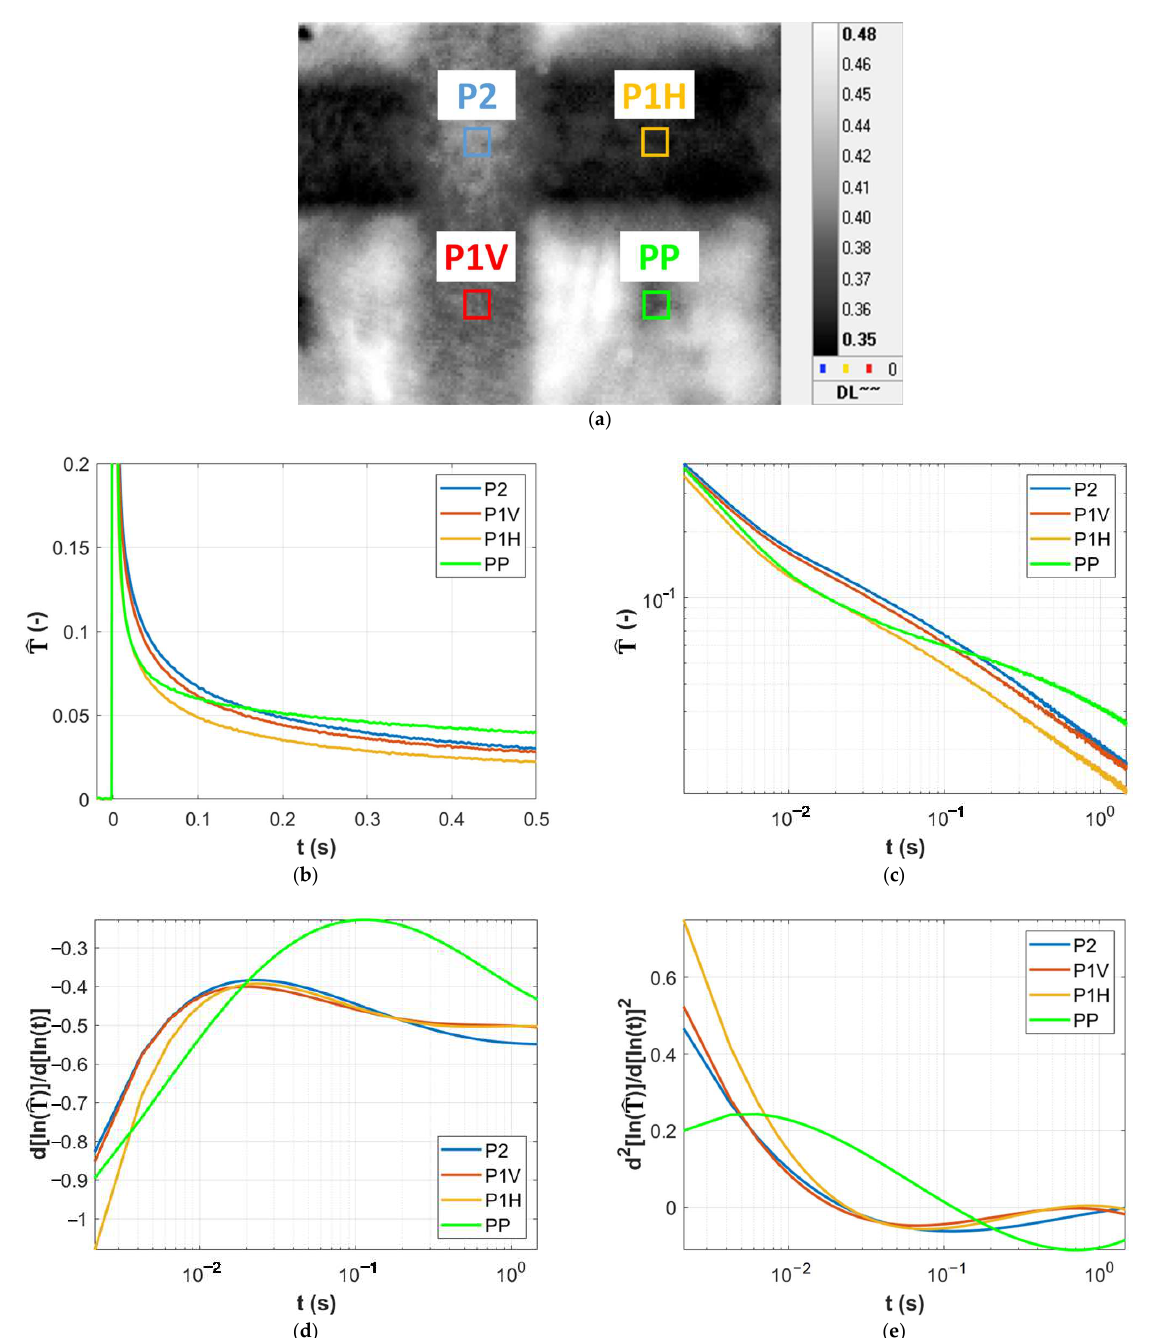
Figure 5. Normalized thermal results: ( a ) normalized thermal map of the ROI at t = 1/472 s, with an indication of the processed regions; ( b ) normalized thermal trend as a function of time, linear scale; ( c ) normalized thermal trend as a function of time, logarithmic scale; ( d ) first derivative of the normalized logarithmic Thermal Signal Reconstruction, semi-logarithmic scale; ( e ) second derivative of the normalized logarithmic Thermal Signal Reconstruction, semi-logarithmic scale.